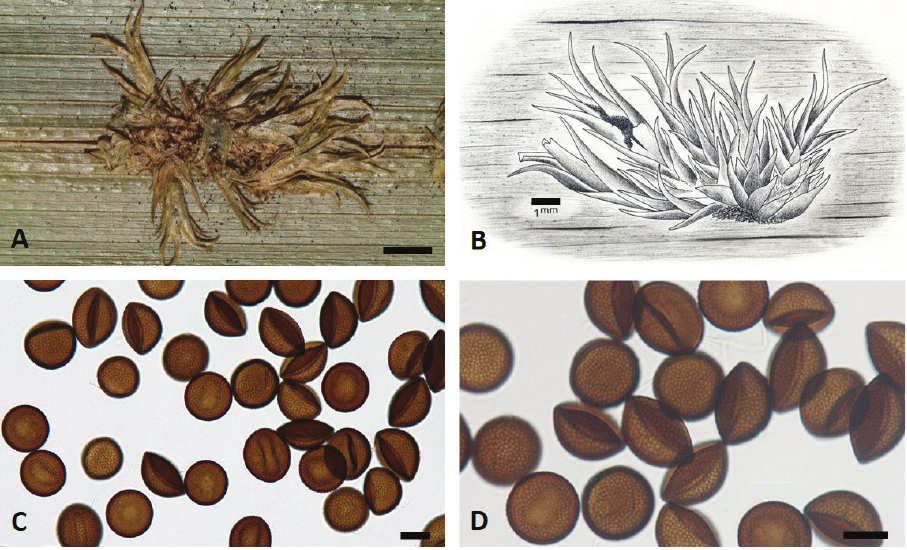
Figure 2. Cintractiella kosraensis (holotype, PTBG-070102) A–B sori on leaf as a photomicrograph ( A Scale bar: 2 mm) and a line drawing ( B Scale bar: 1 mm). C–D teliospores (Scale bars: 25